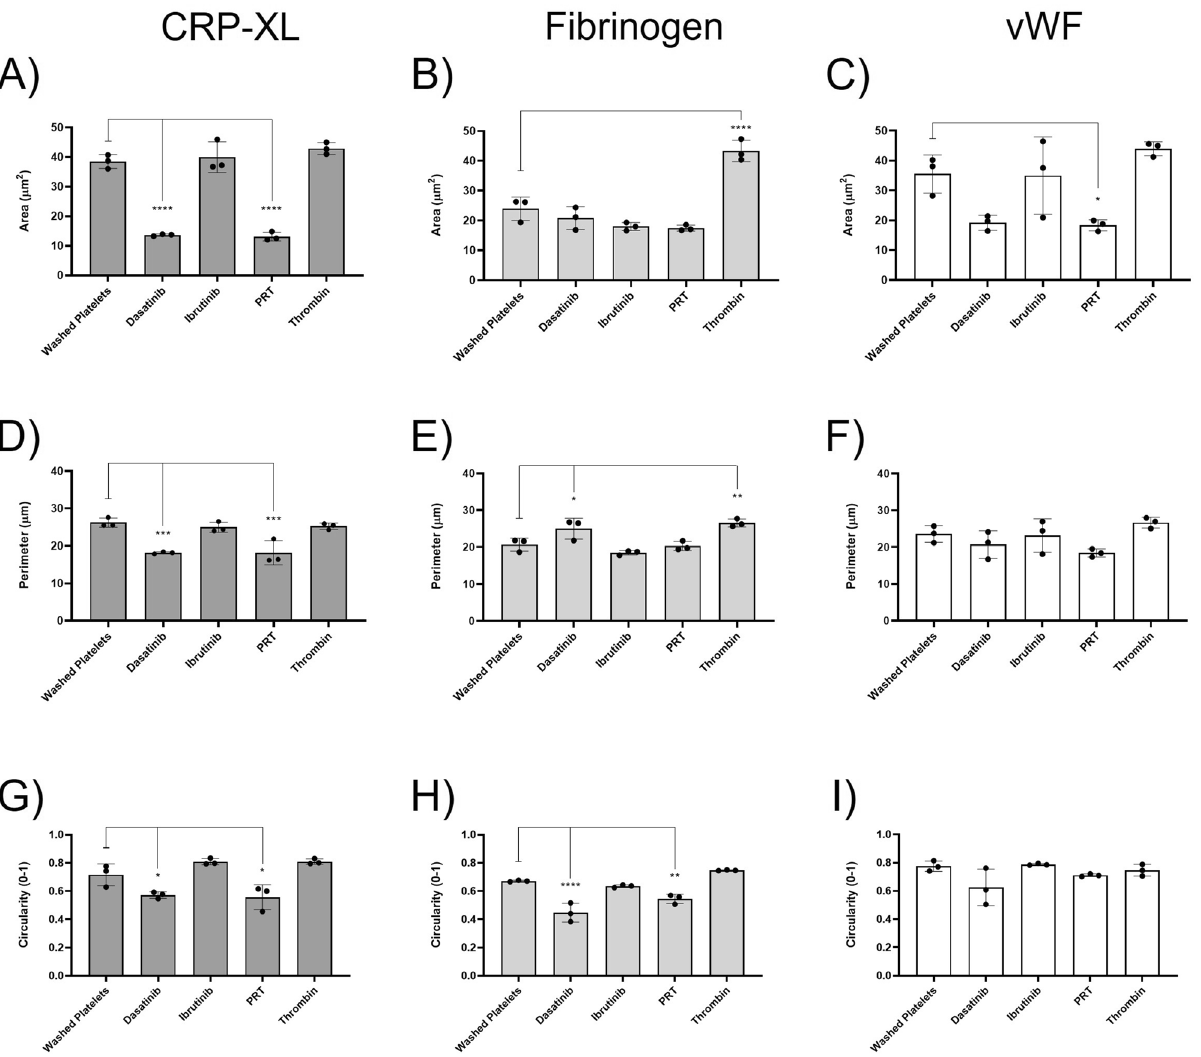
Figure 5. CNN can successfully quantify inhibitor and agonist-induced changes in platelet morphology. Platelet spread area ( A – C ), platelet perimeter ( D – F ) and platelet circularity ( G – I ) were quantified over the three different substrates (CRP-XL ( A , D , G ), Fibrinogen ( B , E , H ) and vWF ( C , F , I )). The mean ± SD of three experimental replicates (n = 3), whereby each experimental replicate was the mean of five fields of view, were plotted and analysed using one-way ANOVA with Bonferroni post-test. *p ≤ 0.05, **p ≤ 0.01, ***p ≤ 0.001, ****p ≤ of the integrin αIIbβ3 to fibrinogen and increased platelet spreading 36 . Dasatinib, ibrutinib and PRT-060318 had no inhibitory effect on the platelet spread area over fibrinogen. PRT-060318 was found to have a significant inhibitory effect on the platelet spread area over a vWF substrate (18.38 ± 1.85 μm 2 ) when compared to control platelets (35.55 ± 6.38 μm 2 ) (Fig. 5C). The role of Syk down stream of glycoprotein Ib (GPIb) is controversial but Syk deficient platelets display inhibited platelet spreading on vWF 37 . Dasatinib, ibrutinib and thrombin had no significant effect on platelet spreading over vWF (Fig. 5C). When observing perimeter measurements (Fig. 5D–F), the CNN identified that dasatinib (18.19 ± 0.25 μm) and PRT-060318 (18.18 ± 3.18 μm) resulted in a significant decrease in platelet perimeter when compared to control platelets on CRP-XL (Fig. 5D). Further supporting the inhibition of Src and Syk signalling pathways which are known to impair platelet spreading on collagen. There was no difference in perimeter measurements between platelets treated with ibrutinib or thrombin. The CNN identified that platelets treated with dasatinib (24.99 ± 2.82 μm) have a significantly increased perimeter when compared to control platelets (20.68 ± 1.73 μm) on fibrinogen (Fig. 5E). Consistent with the literature, dasatinib results in small spikey platelets, described here by a decreased spread area and an increased perimeter. Additionally, when compared to control platelets, there are significant increases in the perimeter when treated with thrombin (26.52 ± 1.07 μm), which is consistent with an increase spread area due to activated αIIbβ3